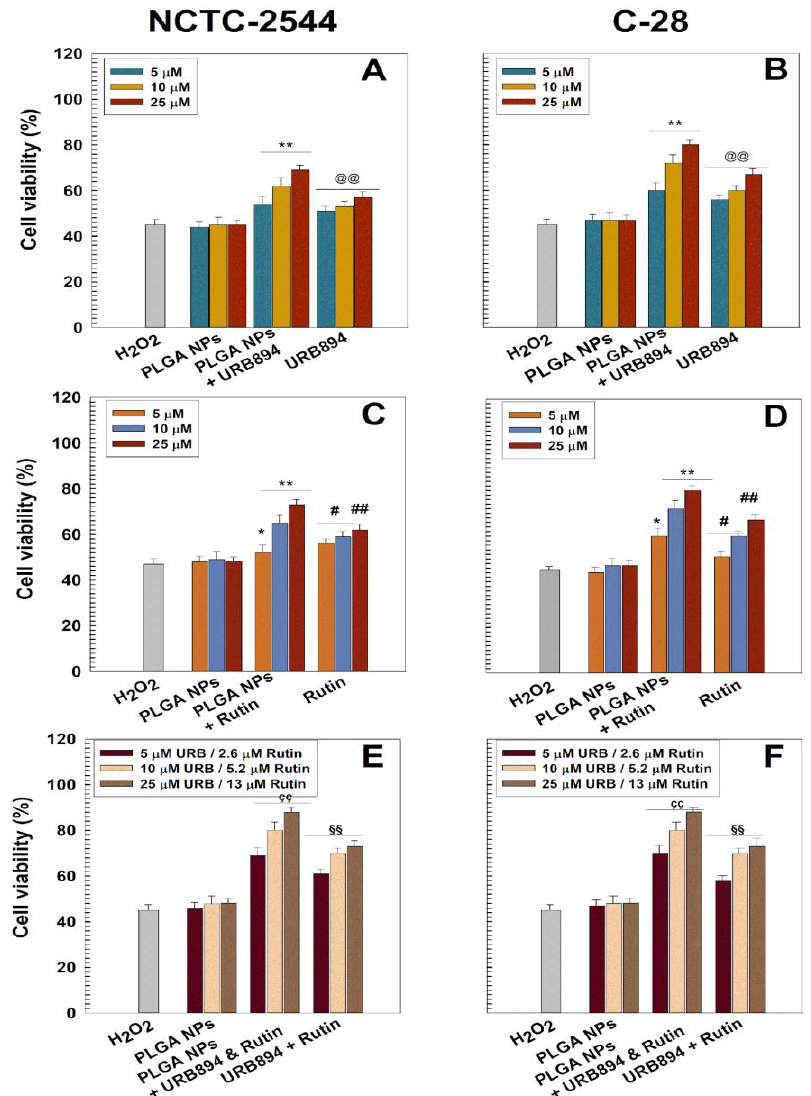
Figure 6. Cell viability during hydrogen peroxide-induced oxidative stress of URB894 ( Panels ( A , B )) and rutin ( Panels ( C , D )) as free form or encapsulated within PLGA nanoparticles (NPs) as single agents or as multidrug formulations ( Panels ( E , F )), evaluated by MTT testing on NCTC-2544 and C-28 cells as a function of the drug concentration. Results are reported as the mean of three different experiments ± standard deviation. The cells were incubated with different concentrations of drug(s) for 24 h and then treated with H 2 O 2 (800 μM) for 1.5 h. * ,#,ç p < 0.05 and ** ,##,çç,§§,@@ p < 0.001: vs . ·H 2 O 2 800 μM.